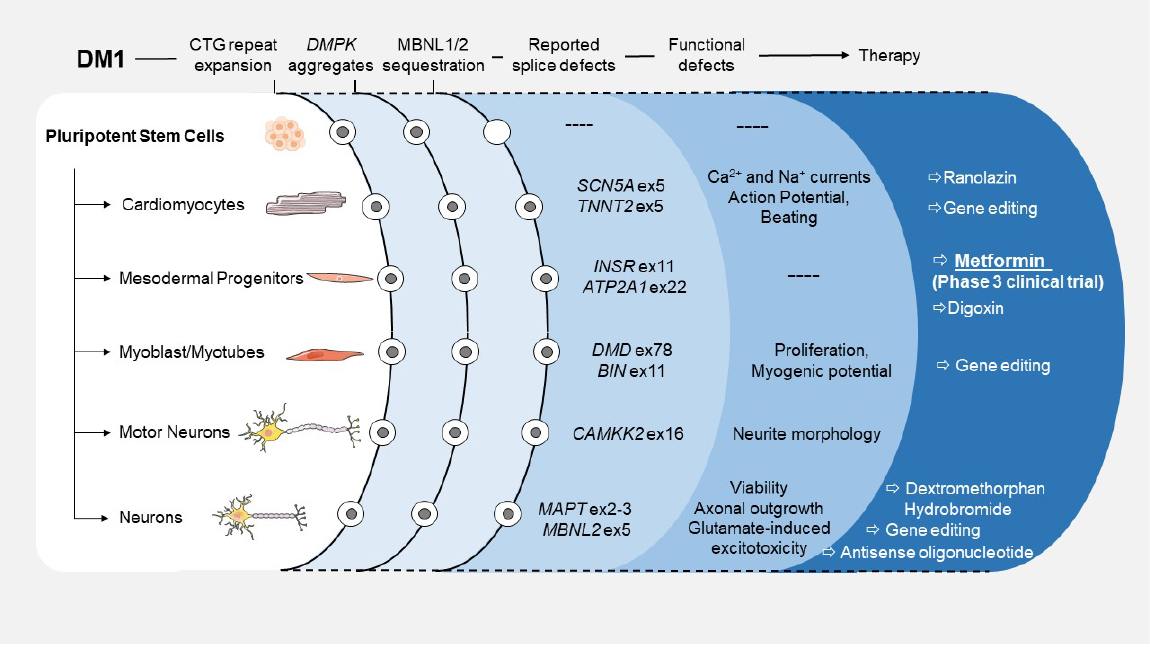
Figure 1. Summary of studies and developments made in in vitro models based on the use of DM1 human pluripotent stem cells and their derivatives. human pluripotent stem cells and their